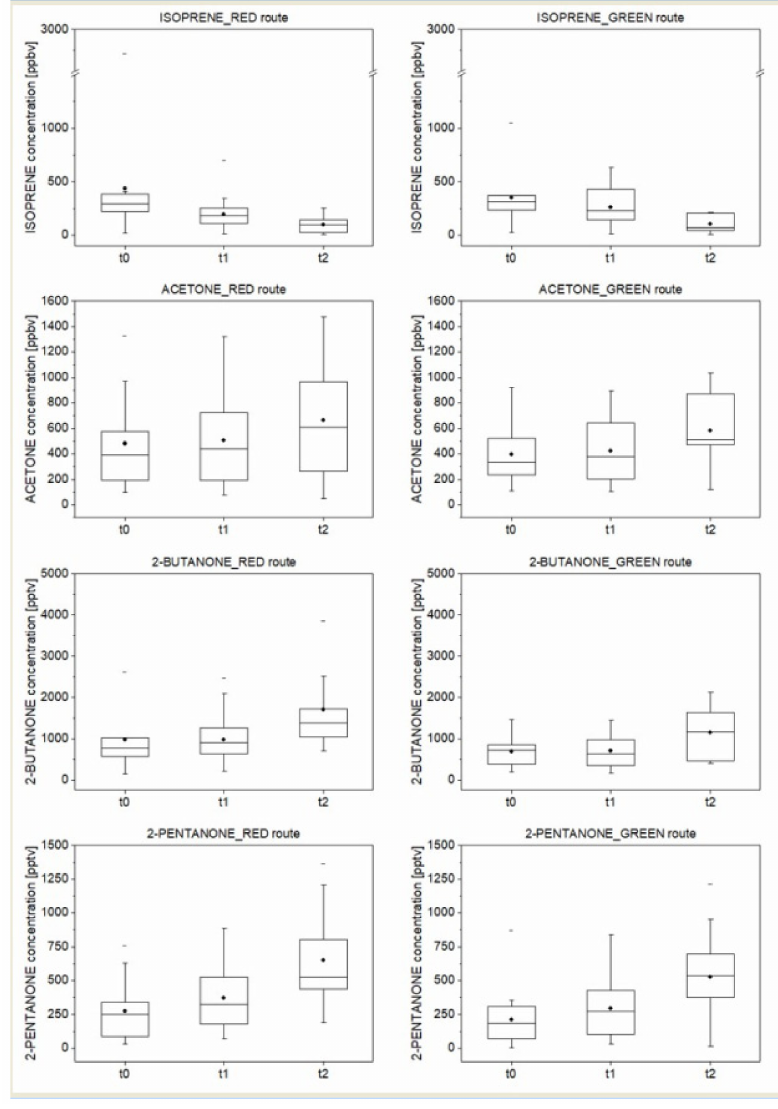
Figure 6. Box-plot of the concentration (expressed in pptv) of metabolic/oxidative stress-associated VOCs measured in the breath sample ( n = 15 subjects) collected at the established times before the walk (t0), at its end (t1), and after the run (t2), during the tests on both green and red routes. Note: The box-plot shows the minimum, the 5th, and the 25th percentiles, the median, the 75th, and 95th percentiles, and the maximum values for each variable investigated. The dot inside the box shows the mean